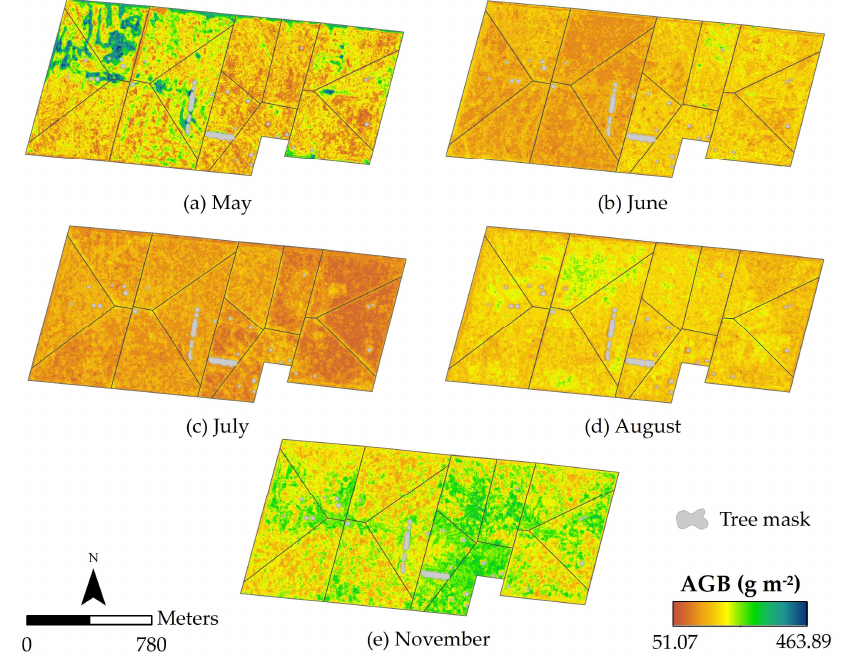
Figure 7. Pasture aboveground biomass (AGB) spatial maps predicted by the best extreme gradient boosting (XGBoost) model for the study area in the months of May ( a ), June ( b ), July ( c ), August ( d ), and November ( e ).